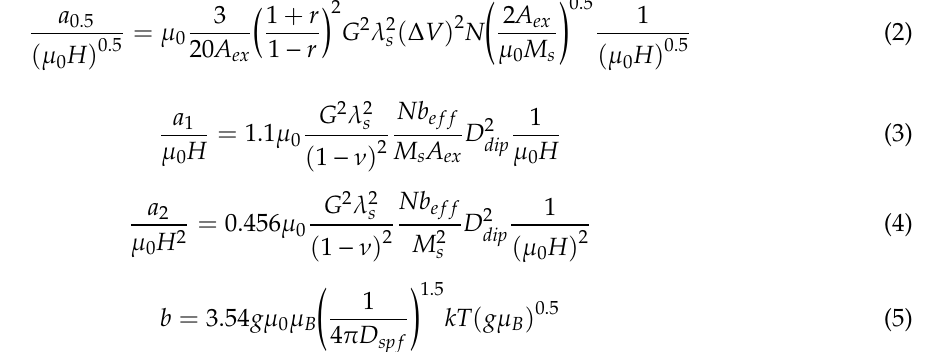
Intensity of the Maximum (a.u.)